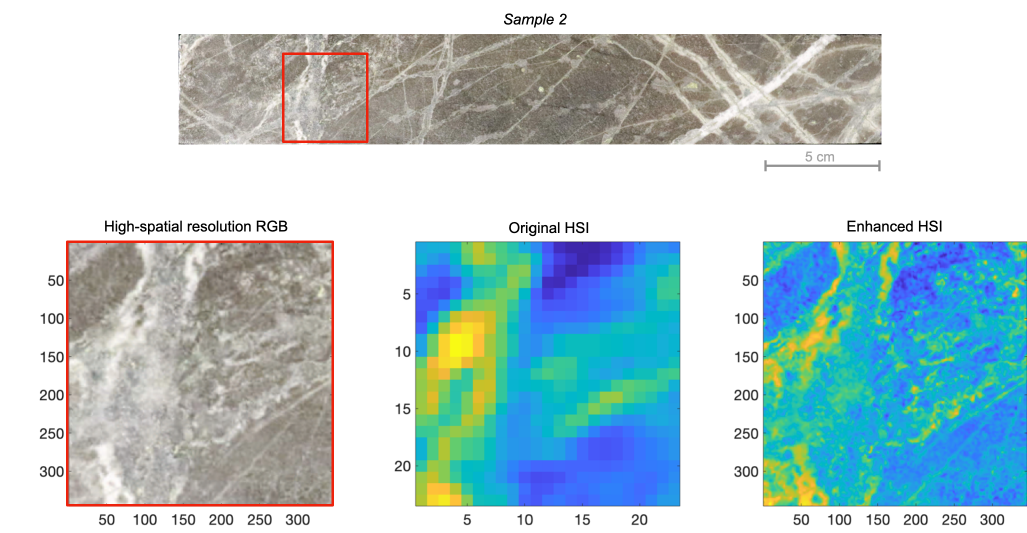
Figure 4. Resolution enhancement example: RGB image of Sample 2 with red square showing an specific region where the enhancement is illustrated. Bottom row shows the RGB image of the specific region, band 889 nm of the original hyperspectral (HSI) data (1.5 mm ground sampling distance (GSD)) and the same band of the enhanced hyperspectral data (0.1 mm